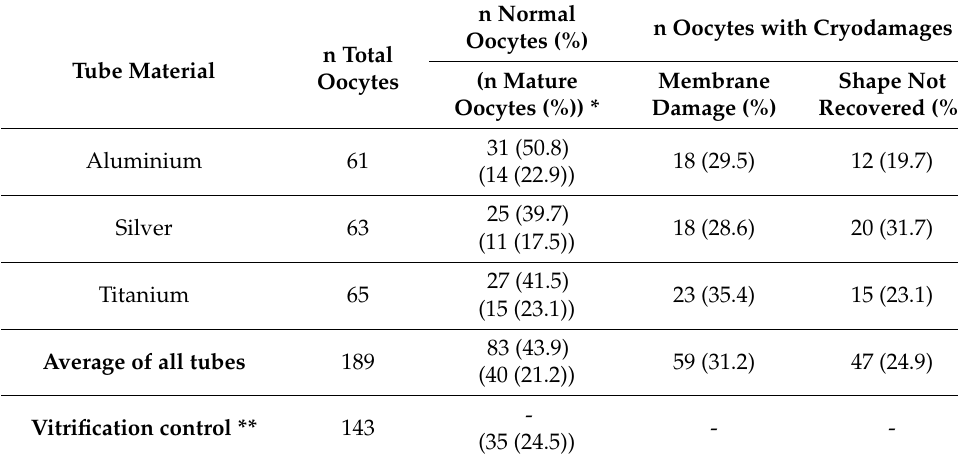
Table 1. Morphological classification after warming and recovery of the oocytes frozen in different metal tubes with the self-pressure